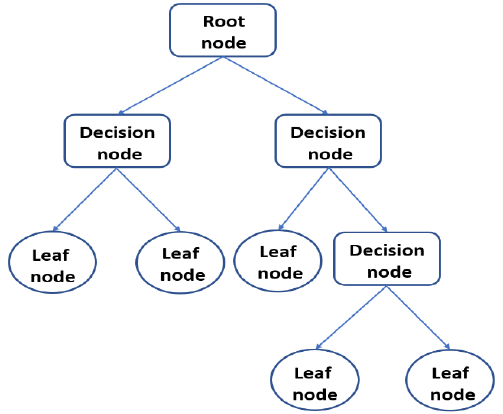
Figure 9. The general scheme of a Decision Tree [25].